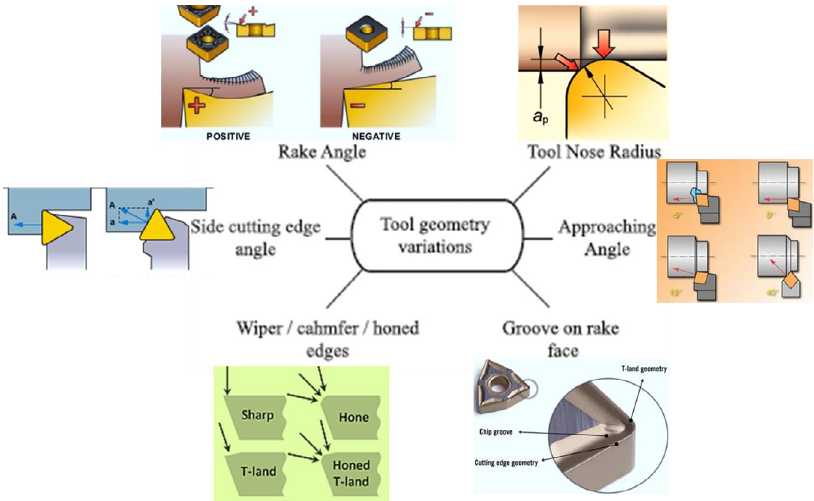
Fig. 6. Illustrations of tool